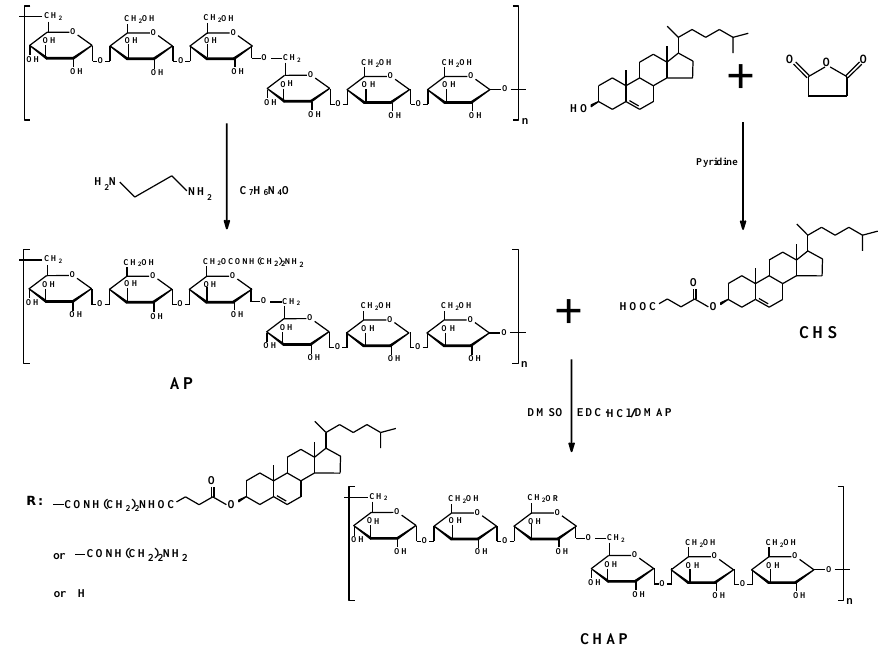
Figure 1. The synthesis route of the cholesterol-modified amino-pullulan (CHAP) conjugate.